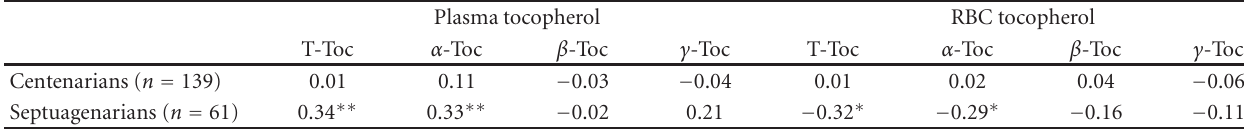
Table 7: Correlation coe ffi cient between tocopherol and plasma lipid